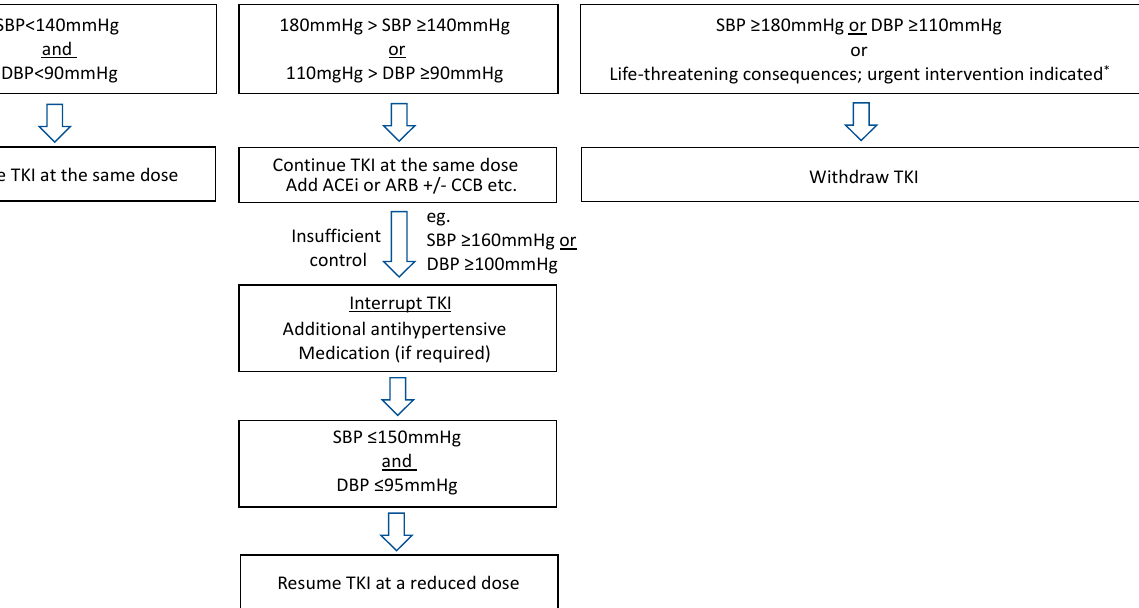
Figure 2. Proposal of management of VEGFR-targeted TKIs-induced hypertension.